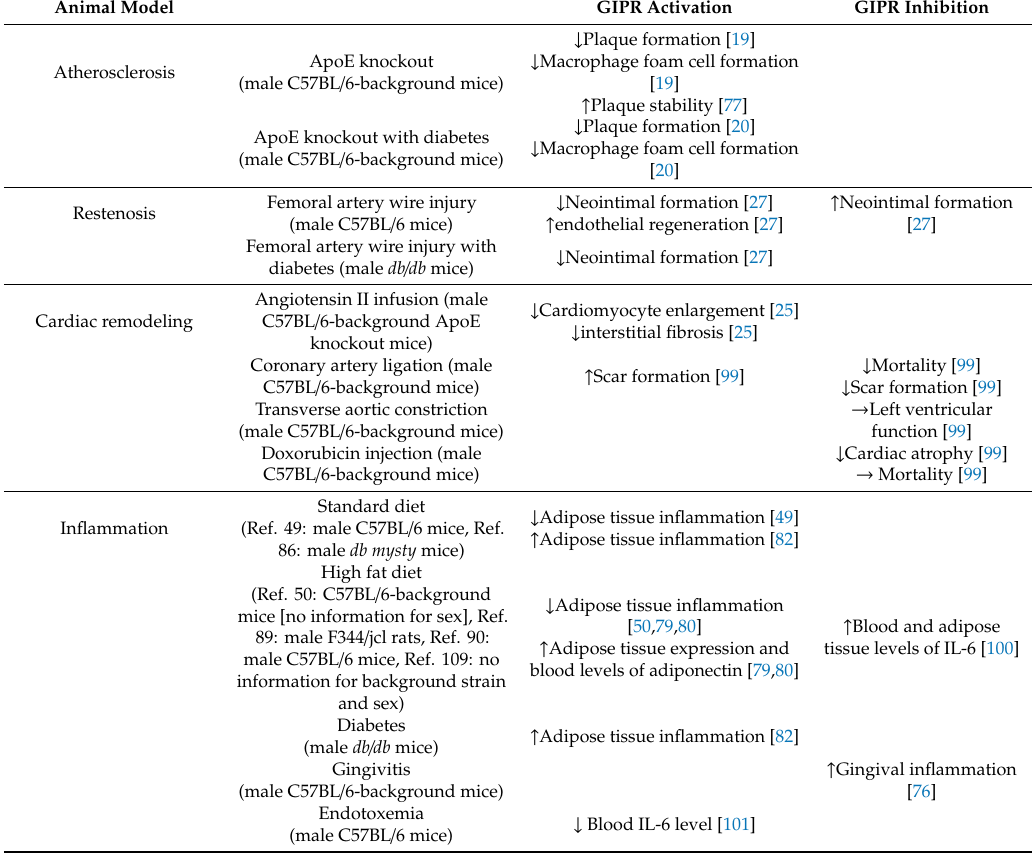
Table 2. Cardiovascular e ff ects of GIP in animal models of cardiovascular disease. ↑ , increase; → , no change; ↓